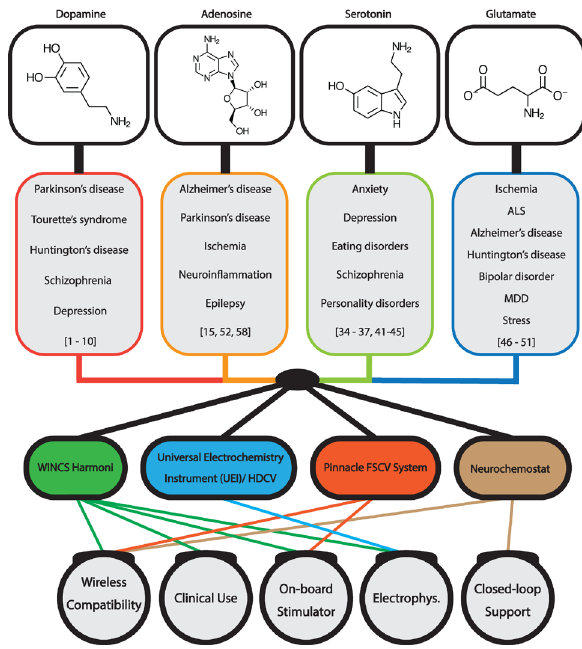
Figure 2: A schematic showcasing disease-relevant biomarkers and applicable neurochemical sensing devices. Abbreviations: MDD – major depressive disorder; HDCV – high-definition cyclic voltammetry; FSCV – fast-scan cyclic